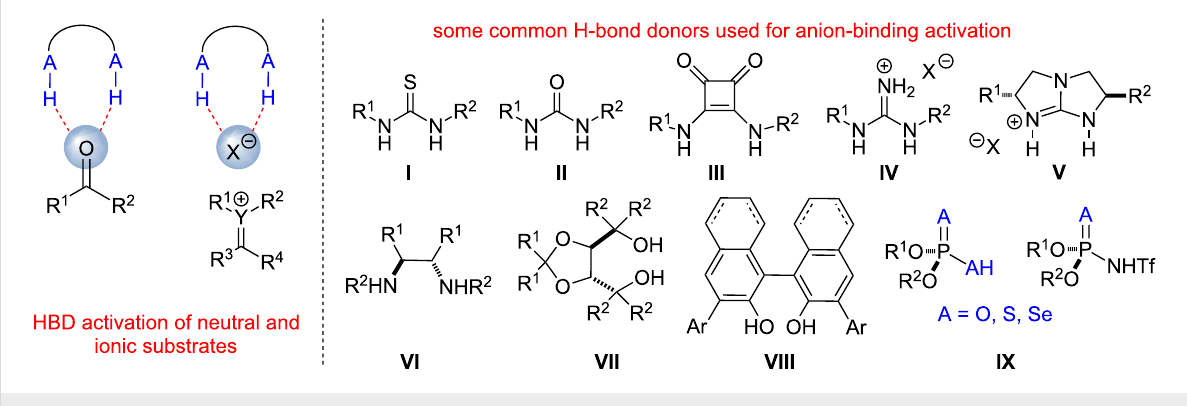
Figure 1: Electrophile Activation by Hydrogen Bond Donors [1-16].